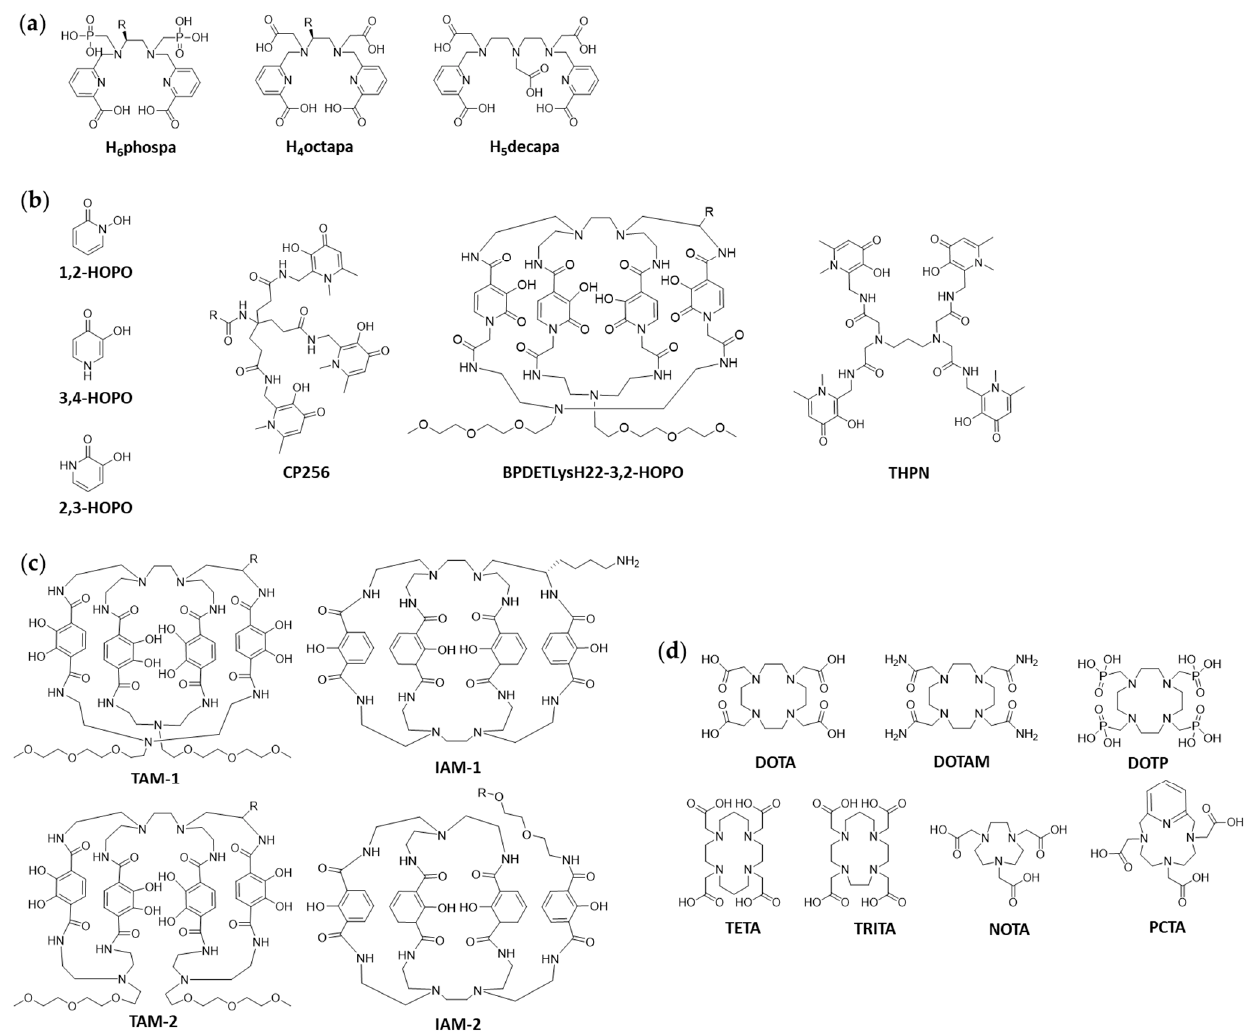
Figure 2. Exemplary structures for non-hydroxamate 89 Zr-chelators. ( a ) Acyclic chelators of “pa” family. ( b ) HOPO-based chelators. ( c ) Terephthalamide- and hydroxyisophthalamide-based chelators. ( d ) Tetraazamacrocycle- and other polyazamacrocycle-based chelators. R represents location of bifunctionalization.